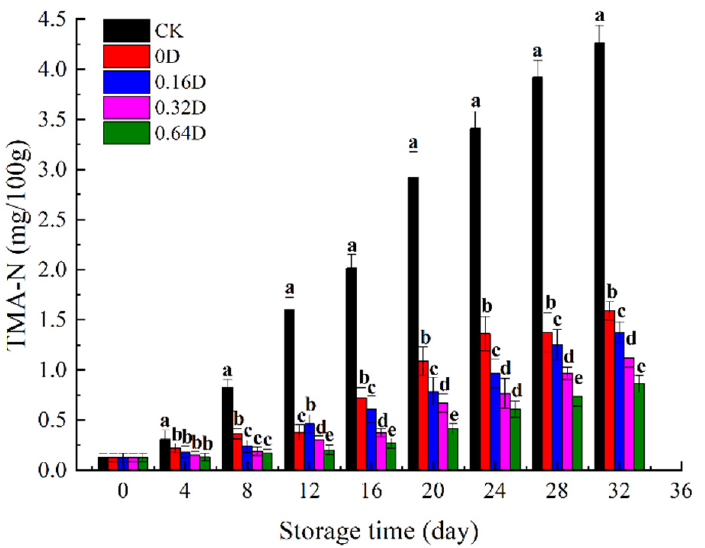
Figure 5. Changes in the TMA value of turbots during refrigerated storage. Different superscript letters a–e indicate significant differences ( p < 0.05).